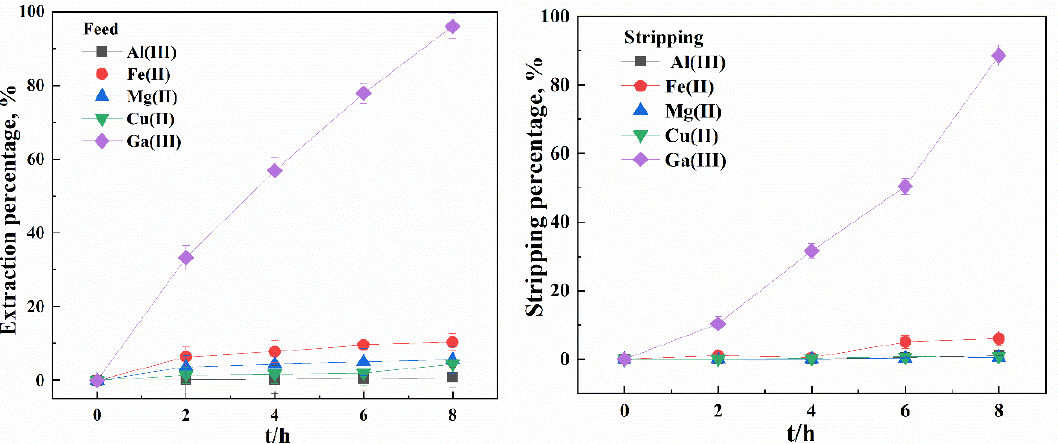
Figure 11. Separation of Ga (III) using R 4 NCy from multicomponent mixed solutions by SLMs ([Ga(III)]/[Al(III)]/[Fe(II)]/[Cu(II)]/[Mg(II)]) feed = 400 mg/L, Carrier = 0.5 M R 4 NCy, Strip: pH = 1).